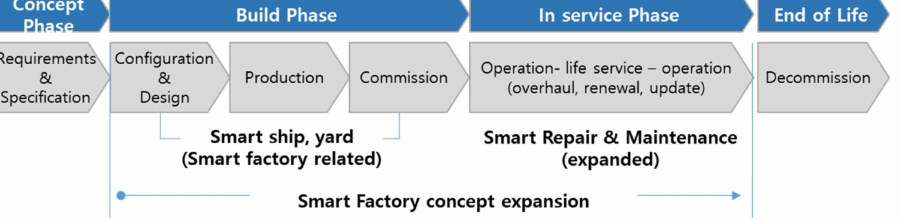
Figure 1. Ship lifecycle and smart factory